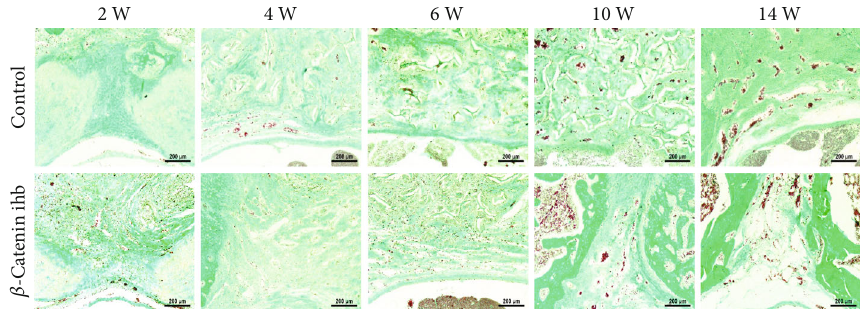
Figure 3: Goldner ’ s trichrome staining of TEL at the 2nd, 4th, 6th, 10th, and 14th weeks.